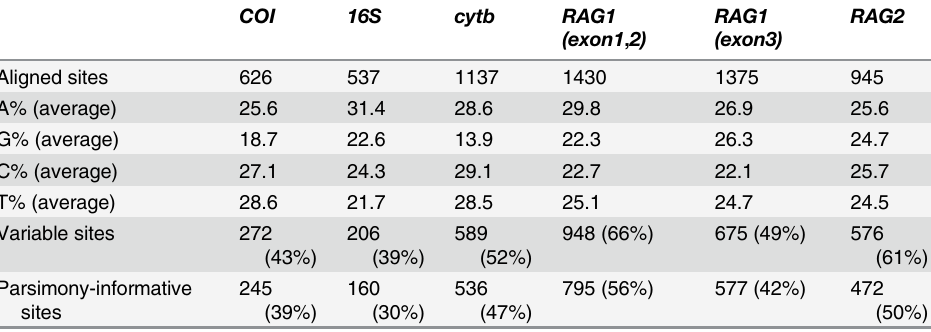
Table 3. Summary statistics for the genes used in this